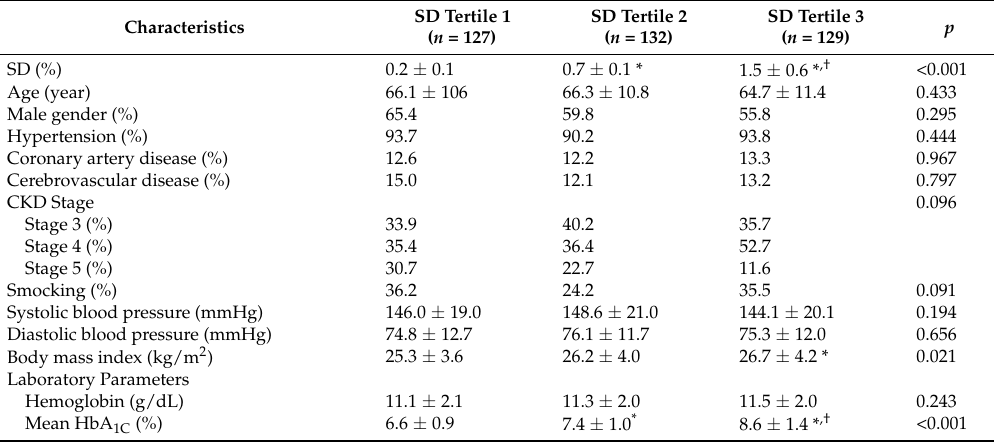
Table 1. Comparison of clinical characteristics according to tertiles of standard deviation (SD) of HbA 1C